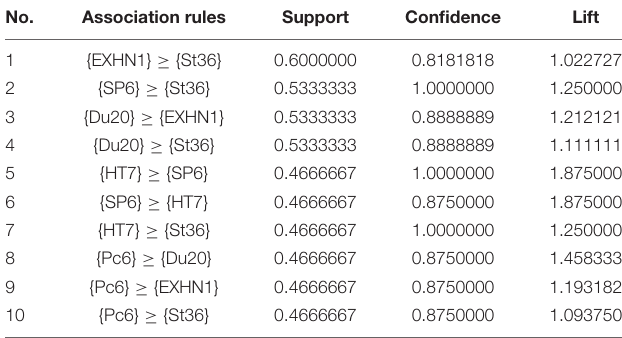
TABLE 1 | Ten most frequent association rules of